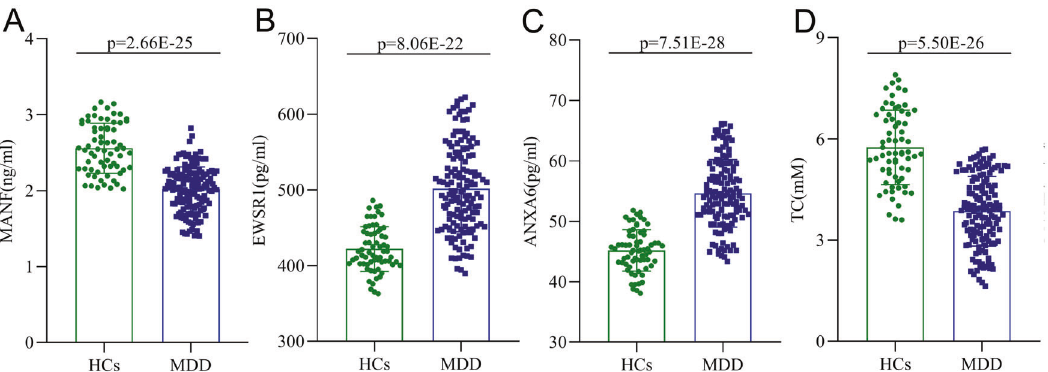
Fig. 3 Levels of MANF, EWSR1, ANXA6, and TC in healthy controls (HCs) and major depressive disorder (MDD) groups. A – C Concentrations of MANF ( A ), EWSR1 ( B ), and ANXA6 ( C ) between the two groups. D The concentration of TC between the two groups. Data are presented as mean ±